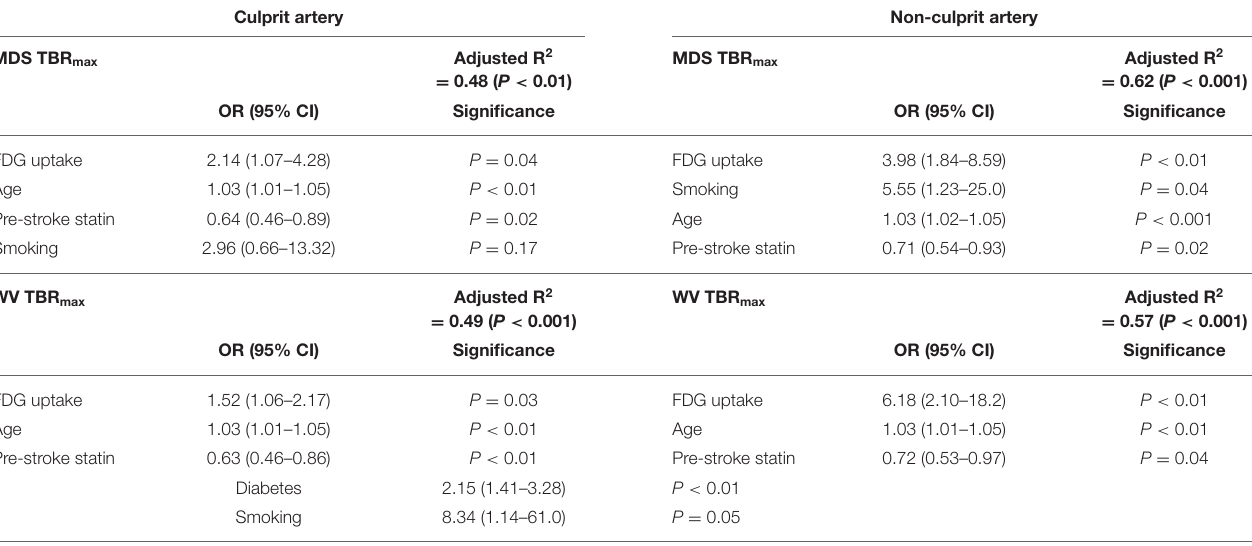
and serum MMP-9 concentrations (23, 32). A 12-week course of atorvastatin 40 mg/day resulted in significant reductions